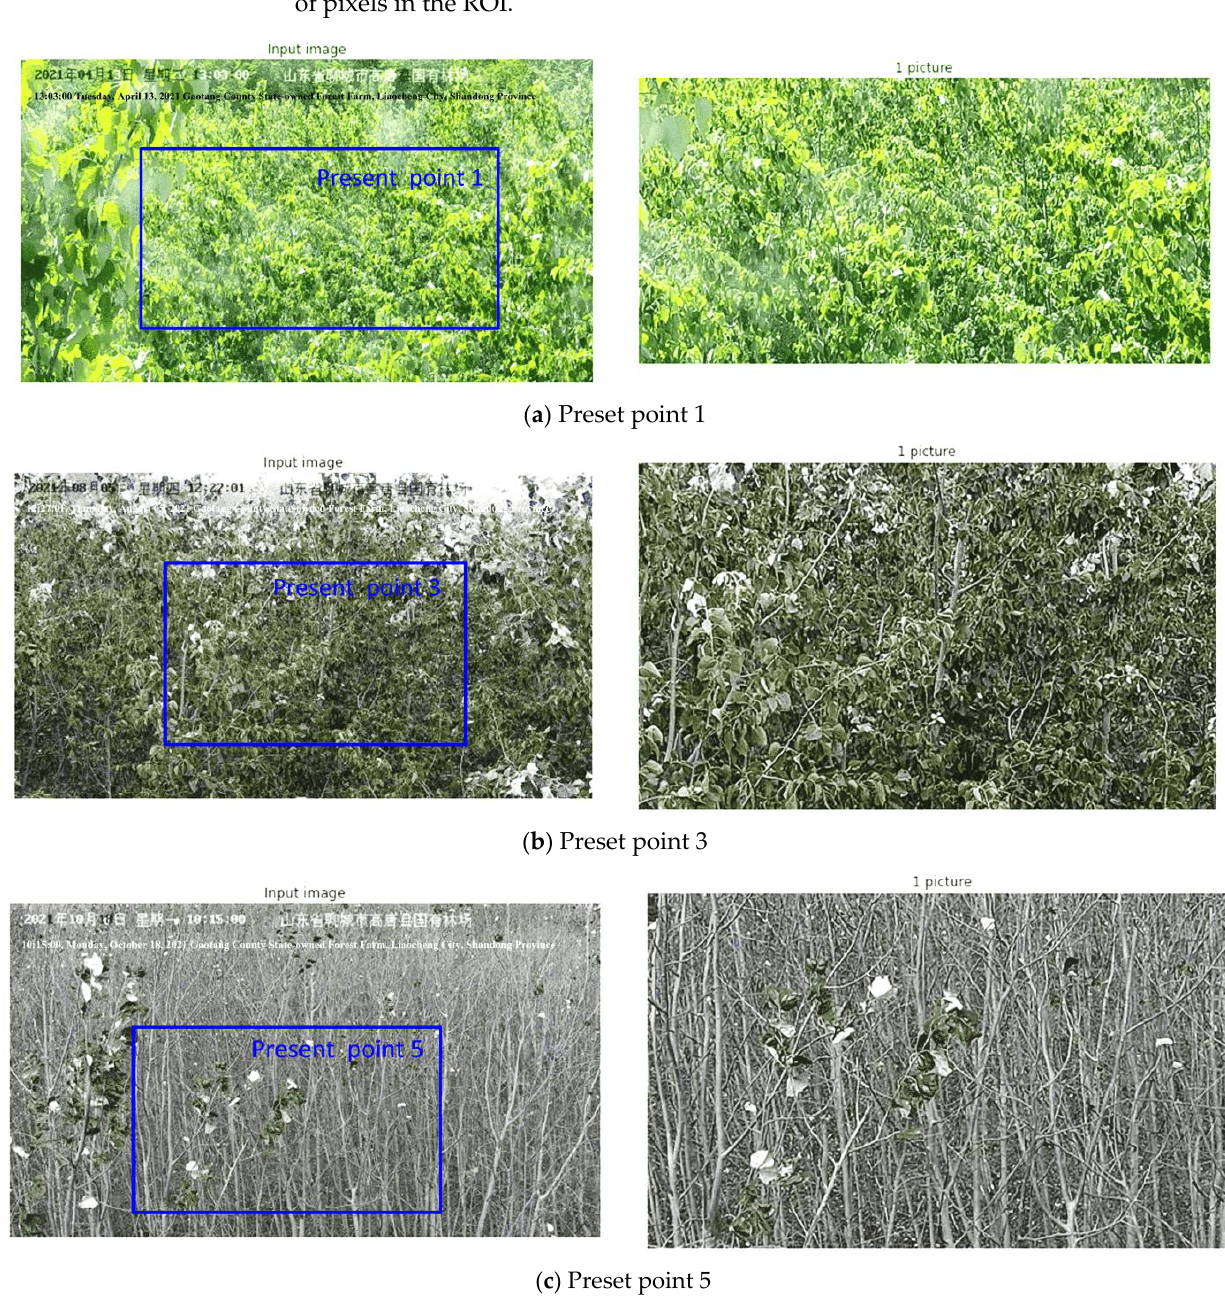
Figure 3. Locations of preset points and regions of interest.